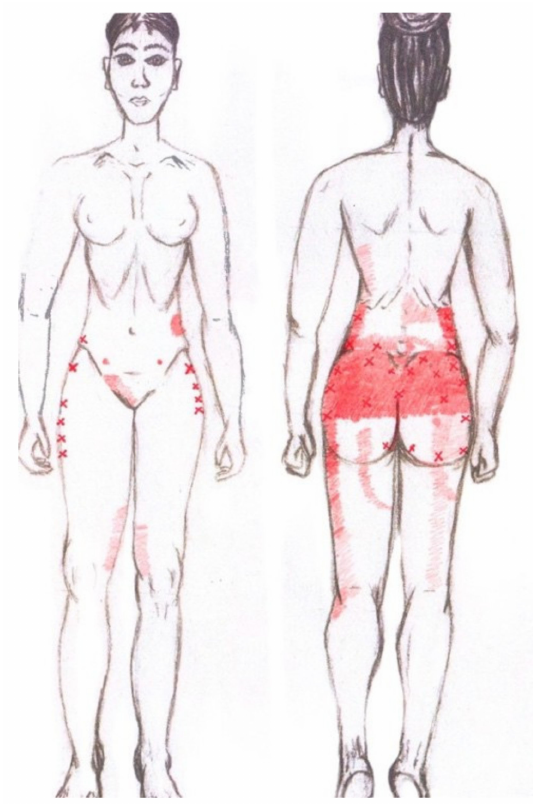
Figure 8. Graphical simulation of referred pain areas of the gluteus maximus muscle.